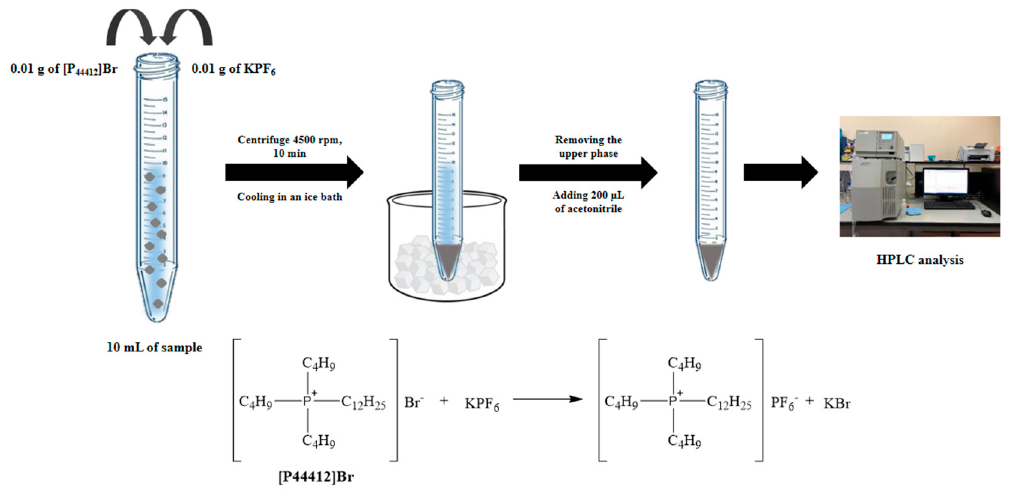
Figure 8. Schematic illustration of the microextraction procedure using in situ formation of the ionic liquid for triazole fungicides and HPLC analysis.